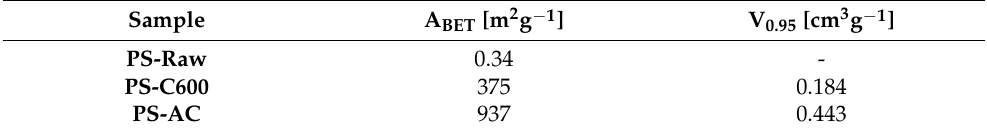
Figure 9. N 2 adsorption-desorption isotherms determined at 77 K on PS-AC (squares) and PS-C600 (circles), with empty and filled symbols corresponding to adsorption and desorption, respectively. Table 4. BET area (A BET ) of raw biomass and biochars determined by analysis of Kr and N 2 adsorption at 77 K, respectively, and volume of N 2 adsorbed at p/p o = 0.95 (V 0.95 ).